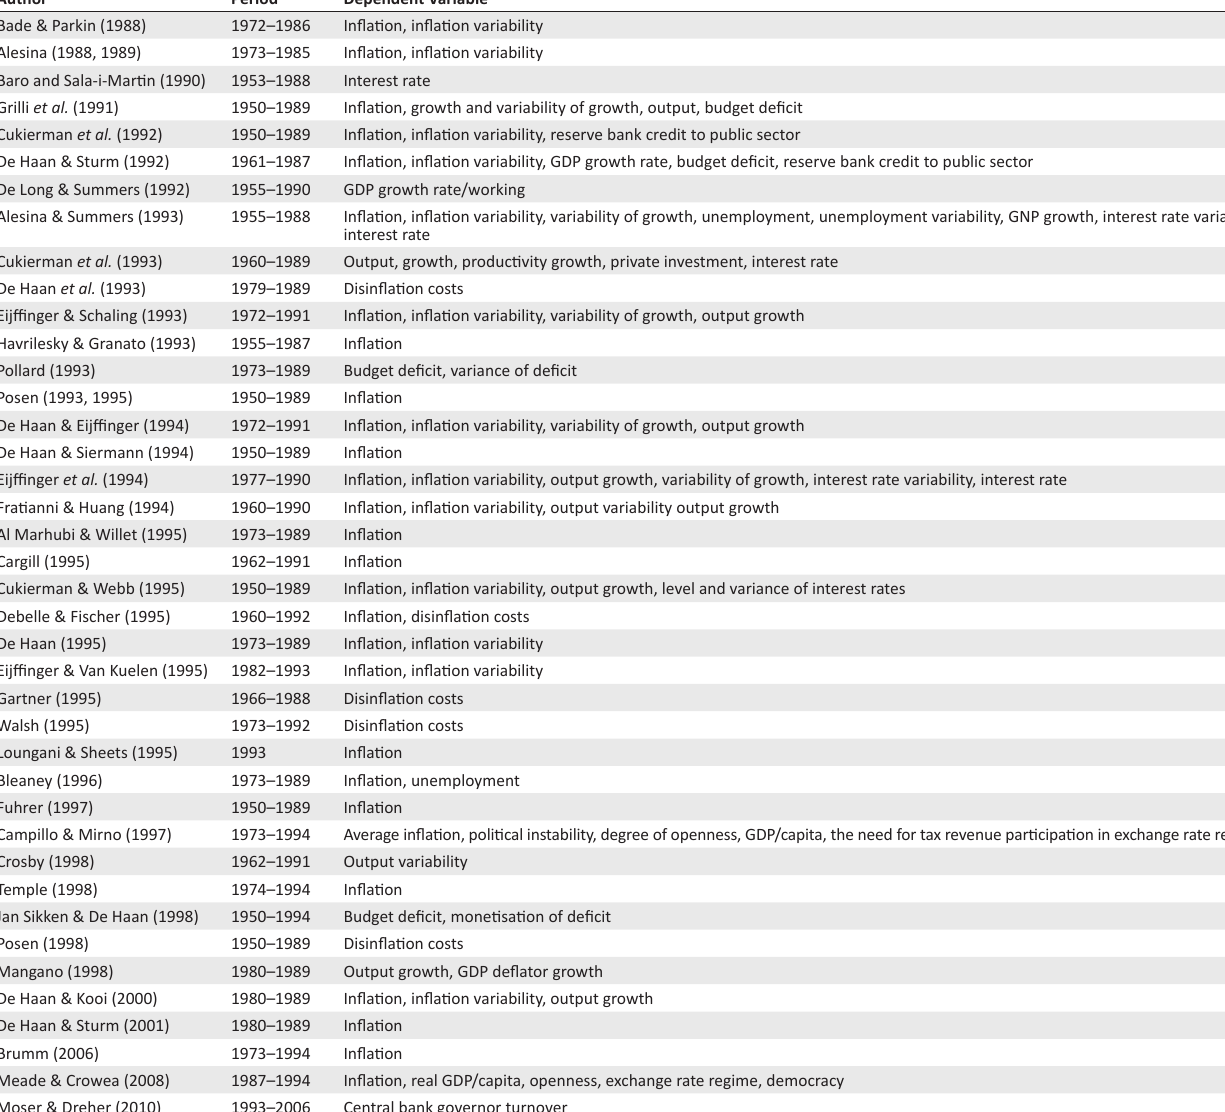
TABLE 1: Variables used in determining central bank